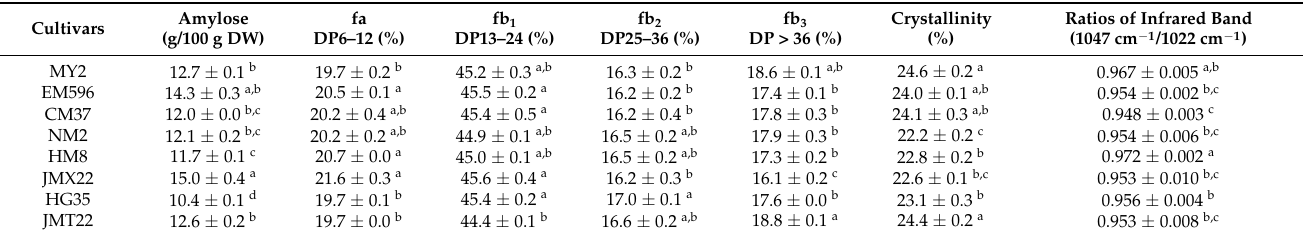
Table 2. Amylose content, crystalline property, and amylopectin weight-based chain-length distribution of starch from wheat varying in grain hardness index.